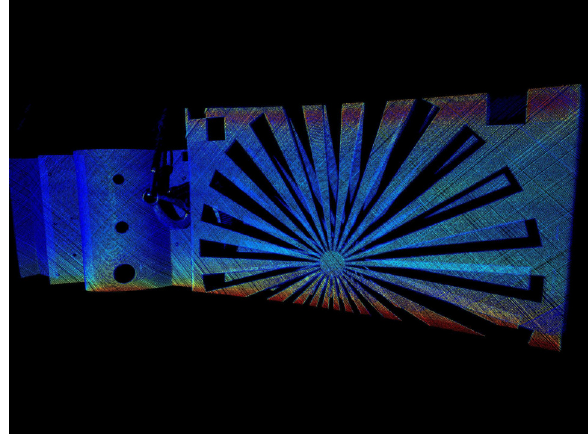
Figure 3. Example scan of the structured light scanner colored by intensity. The scan shows test objects build by IMAWIS GmbH and Fraunhofer IGP in Rostock. The scan was acquired in the towing tank at the University of Rostock.